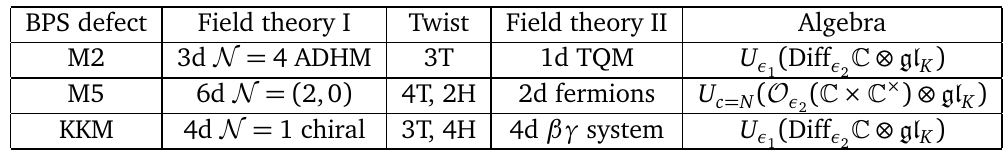
Table 1: Summary of BPS defects, associated field theory, twists, protected subsectors of the field theory, and algebras. ADHM means the G = U ( N ) gauge theory with 1 adjoint hypermultiplet and K fundamental hypermultiplets. T and H stand for topological and holomorphic twists. Field theories I and II are the original theories of the relevant branes and their protected subsectors. TQM is an abbreviation of topological quantum mechanics.